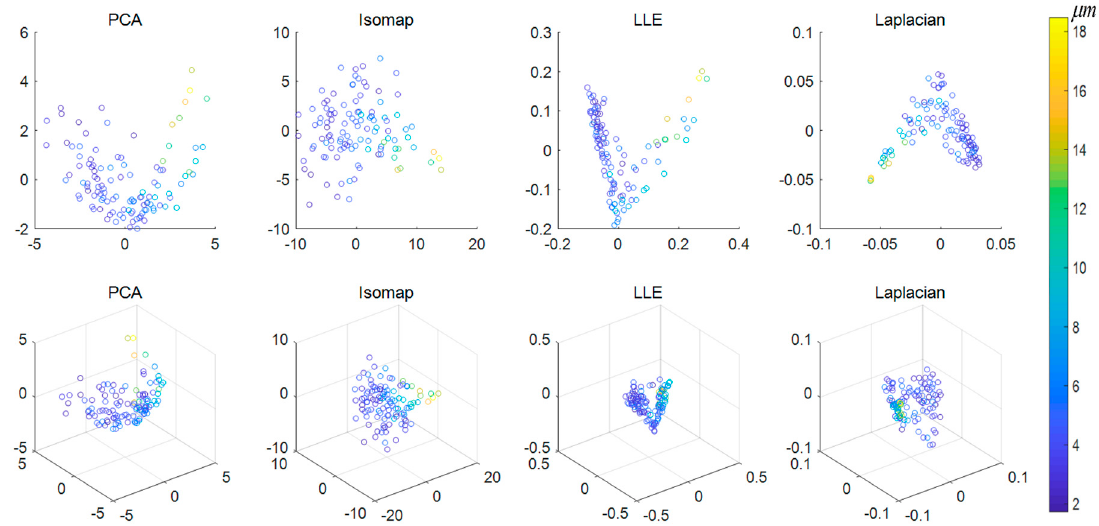
Figure 8. The two-dimensional (2D, top row) and three-dimensional (3D) visualization (bottom row) of the depth-labeled samples after dimensionality reduction.